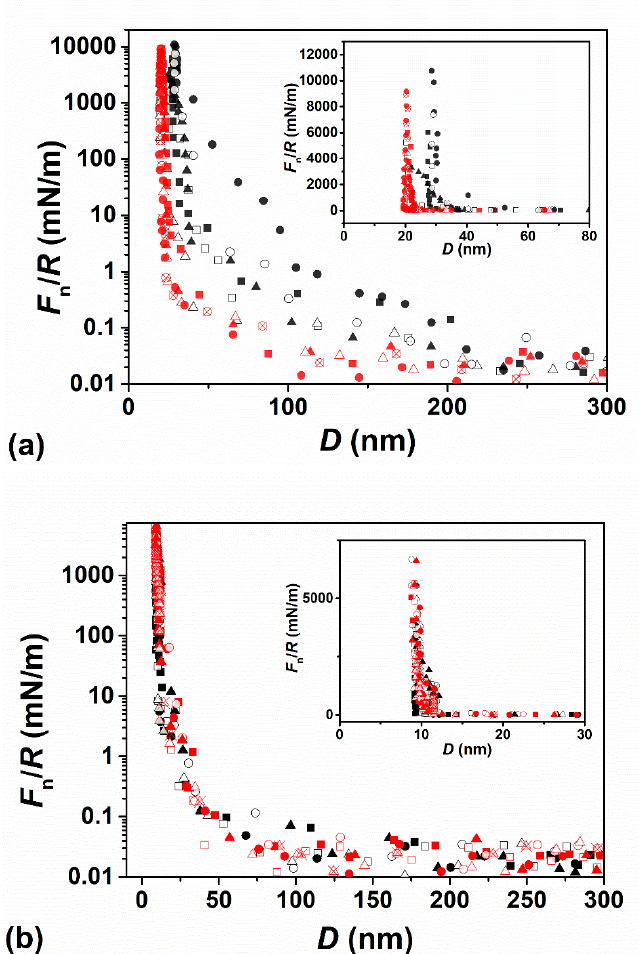
Figure 5. ( a ) Normal force profiles F n ( D )/ R versus separation D between two mica surfaces across pure water (black symbols) following overnight incubation in HSPC small unilamellar vesicle (SUV) dispersion (0.3 mM) followed by washing, and thereafter across HA solution (red symbols), normalized in the Derjaguin approximation by the mean radius of curvature of the mica sheets ( R ). ( b ) Normalized force profiles F n ( D )/ R versus separation D between two mica surfaces across POPC dispersion (0.3 mM, black symbols) following overnight incubation, and then across the HA–POPC mixture (0.5 mg/mL:0.3 mM, red symbols). The zero of separation ( D = 0) is with respect to air contact between bare mica surfaces. The insets show the ‘hard wall’ behavior on a larger, linear–linear scale with the same data points as in the main figure; in ( a ) the hard wall in HA-free water (black symbols) is generally at ca. 30 nm (and occasionally at ca. 20 nm), and in HA solution it is consistently at ca. 20 nm; in ( b ) the hard wall is at ca. 10 nm in both POPC dispersion and in the HA–POPC mixture. Different shaped symbols correspond to different contact positions based on 5 independent experiments with first approaches (filled symbols), second approaches (empty symbols), and receding profiles (crossed symbols).